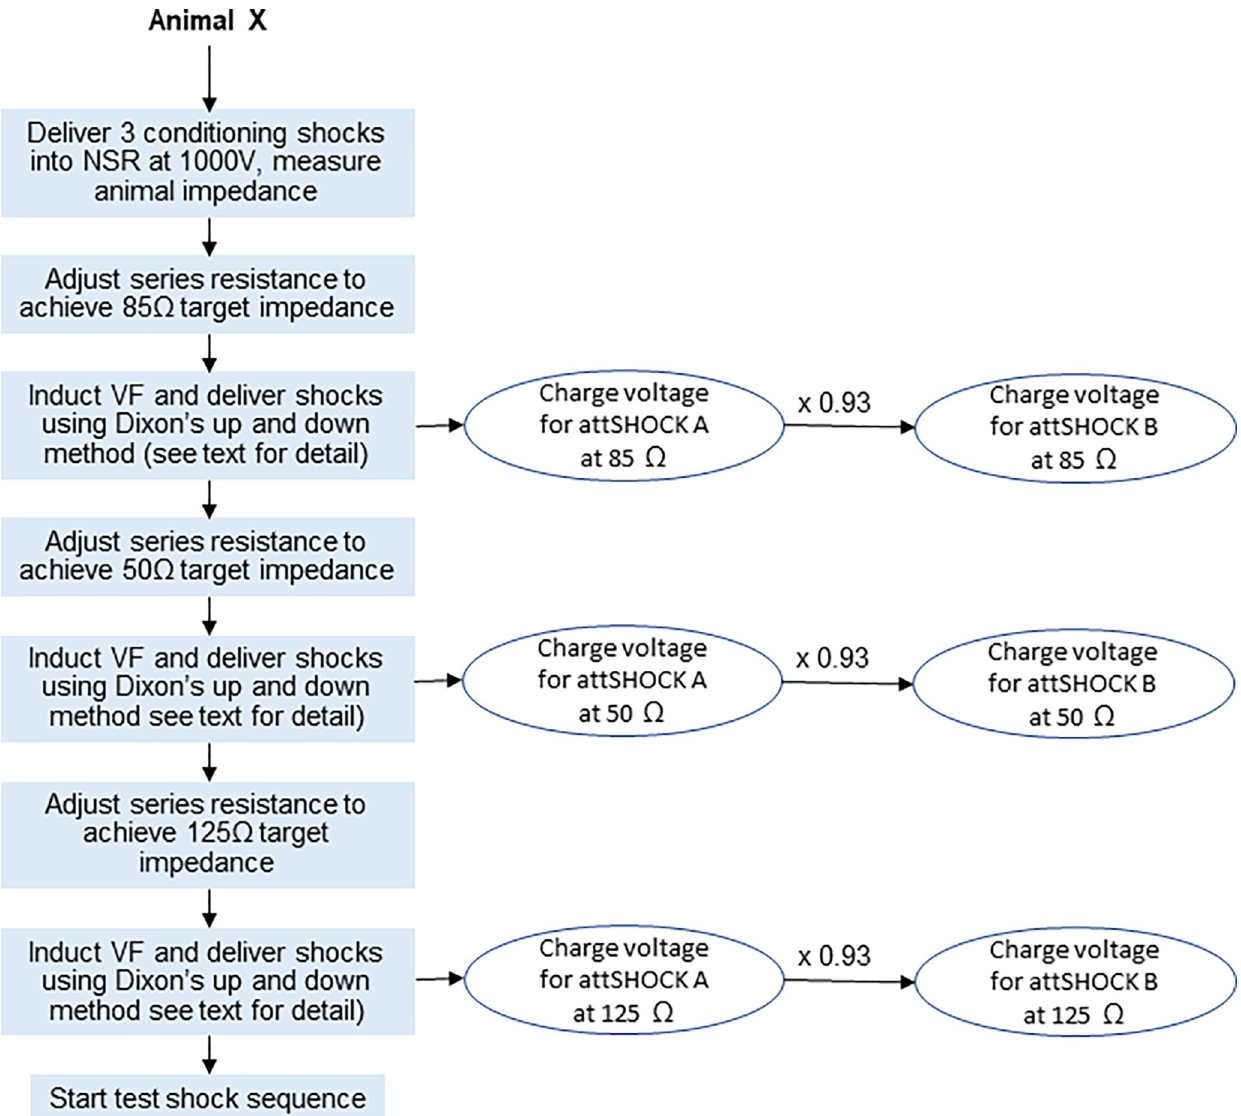
Fig 6. Animal Study #2 charge voltage determination. Image illustrating the process to establish the charge voltage for 50% defibrillation success of attSHOCK A and the subsequent calculation of the charge voltage for attSHOCK B at each target impedance. NSR = normal sinus rhythm, att = attenuated.